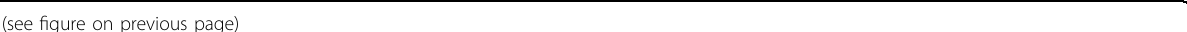
Fig. 2 De fi cits in social behavior of A350V Iqsec2 mice. A, B Mean investigation time measured separately for each stimulus (20-s bins) across the SP test for WT ( A , n = 19) and A350V ( B , n = 20) mice. C Mean investigation time summed separately for each stimulus throughout the SP test for WT (left) and A350V (right) subjects. D – F Same in A – C , for the SNP test (WT - n = 19, A350V – n = 20). ( G – I ) Same in A-C, for the SxP test (WT - n = 33, A350V – n = 36). J – L Same in A-C, for the ESP test (WT - n = 28, A350V – n = 43). ( M-P ) Mean investigation time of WT (above) and A350V (below) mice for each of the stimuli, pooled separately for short (<7 s) and long ( ≥ 7 s) investigation bouts, for the SP ( M ), SNP (N), SxP ( O ), and ESP ( P ) tests shown above ( A – L ). Note that A350V mice showed an atypical signi fi cant preference for the group-housed stimulus when short bouts were considered. Post hoc paired t-tests following the main effect in mixed model ANOVA test; M- WT: short bouts: t 18 = − 0.159, p = 0.876, long bouts: t 18 = 3.109, p < 0.01; A350V: short bouts: t 19 = 1.277, p = 0.217, long bouts: t 19 = 6.7, p < 0.001; N- WT: short bouts: t 18 = − 2.286, p < 0.05, long